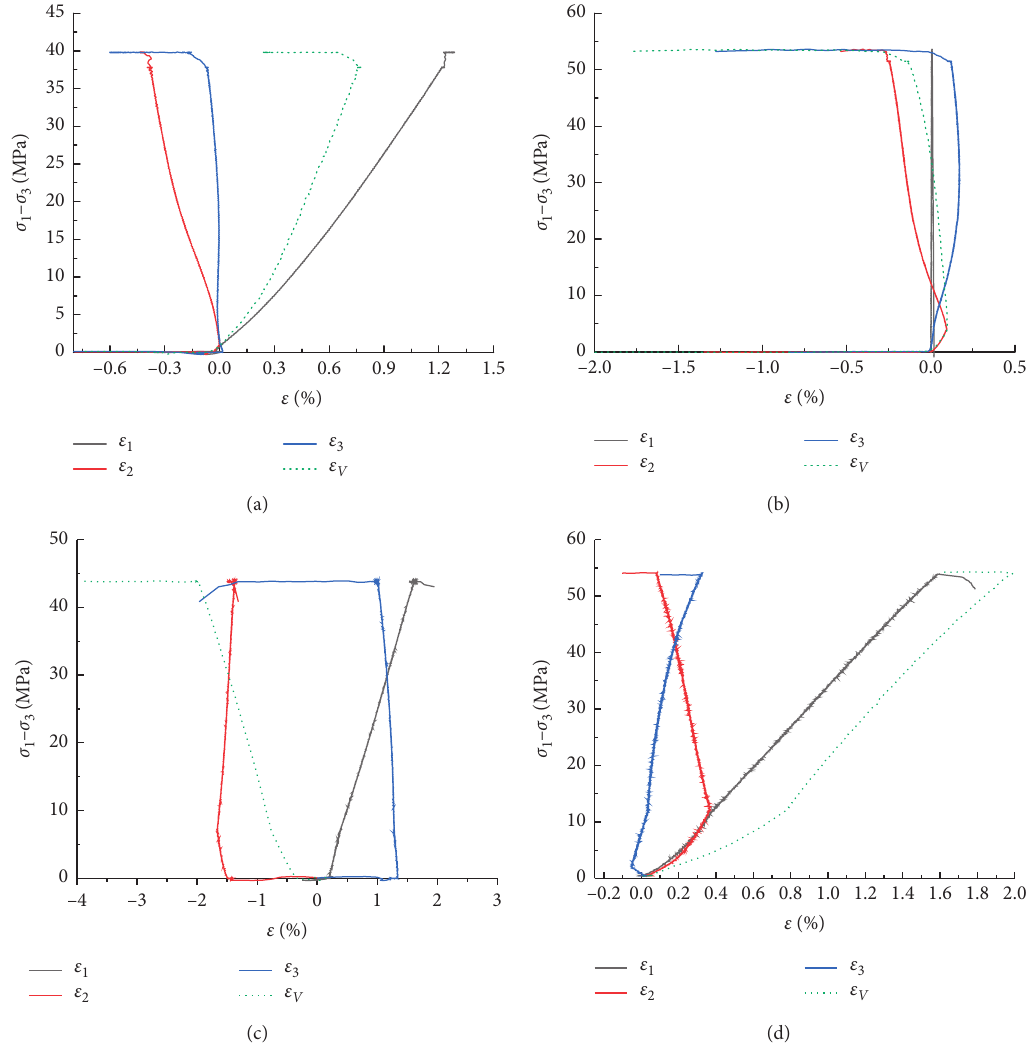
Figure 4: True triaxial unloading test stress-strain curve. (a) Intermediate principal stress is 3MPa. (b) Intermediate principal stress is 6MPa. (c) Intermediate principal stress is 9MPa. (d) Intermediate principal stress is